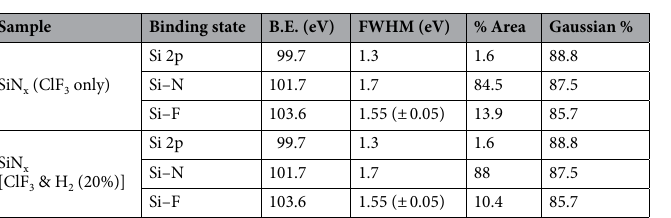
Table 1. Parameters related with the curve fitting of silicon nitride (SiN x ) thin films after exposure to the ClF 3 only and ClF 3 & H 2 (20%)